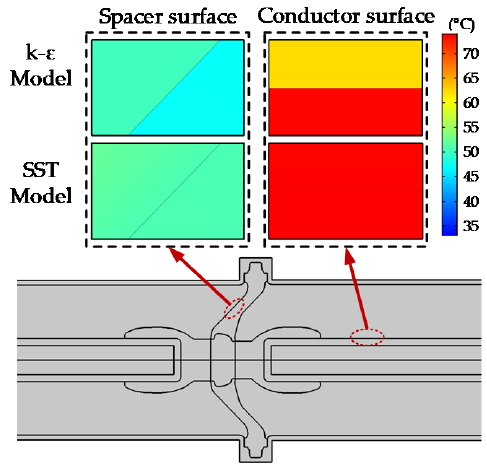
Figure 3. Temperature distribution at the gas–solid interface with different turbulence models.